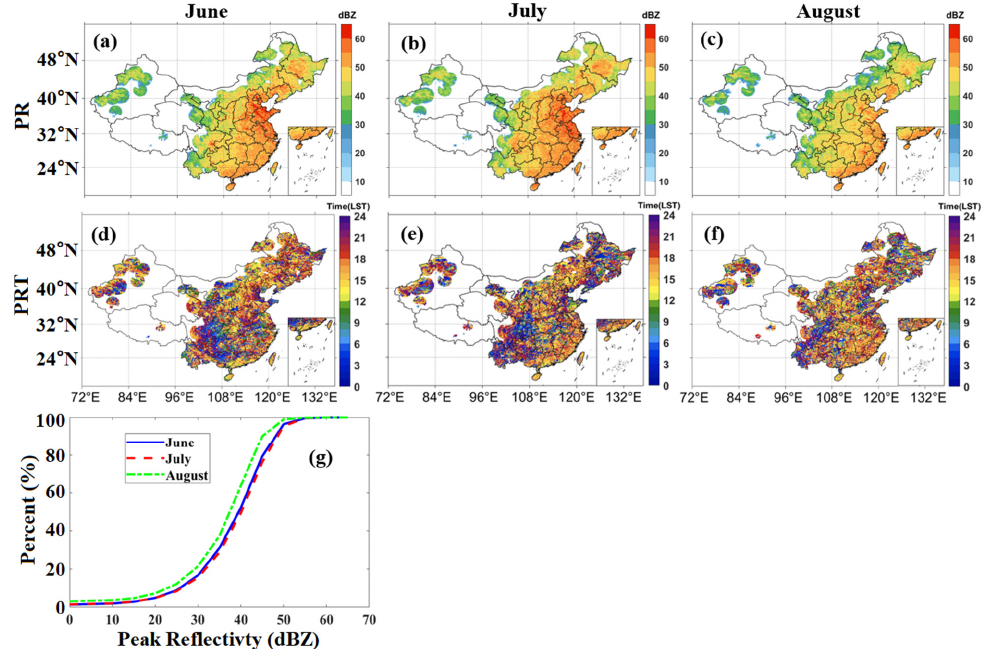
Figure 6. ( a – f ) Peak reflectivity (PR) and the timing of peaks in reflectivity (PRT) over China from June to August. ( g ) Cumulative probability distributions from June to August.